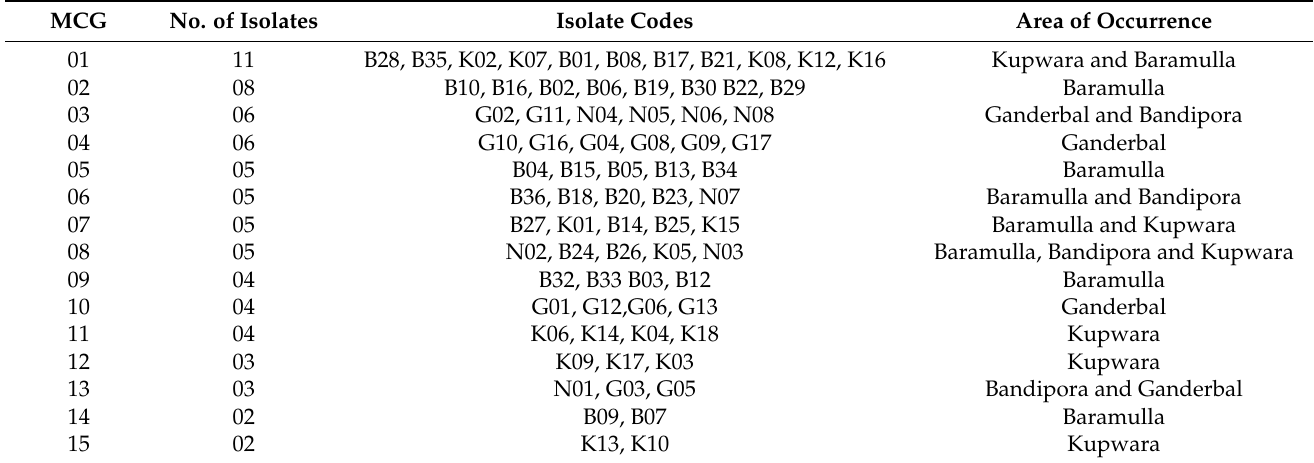
B36, B18, B20, B23,